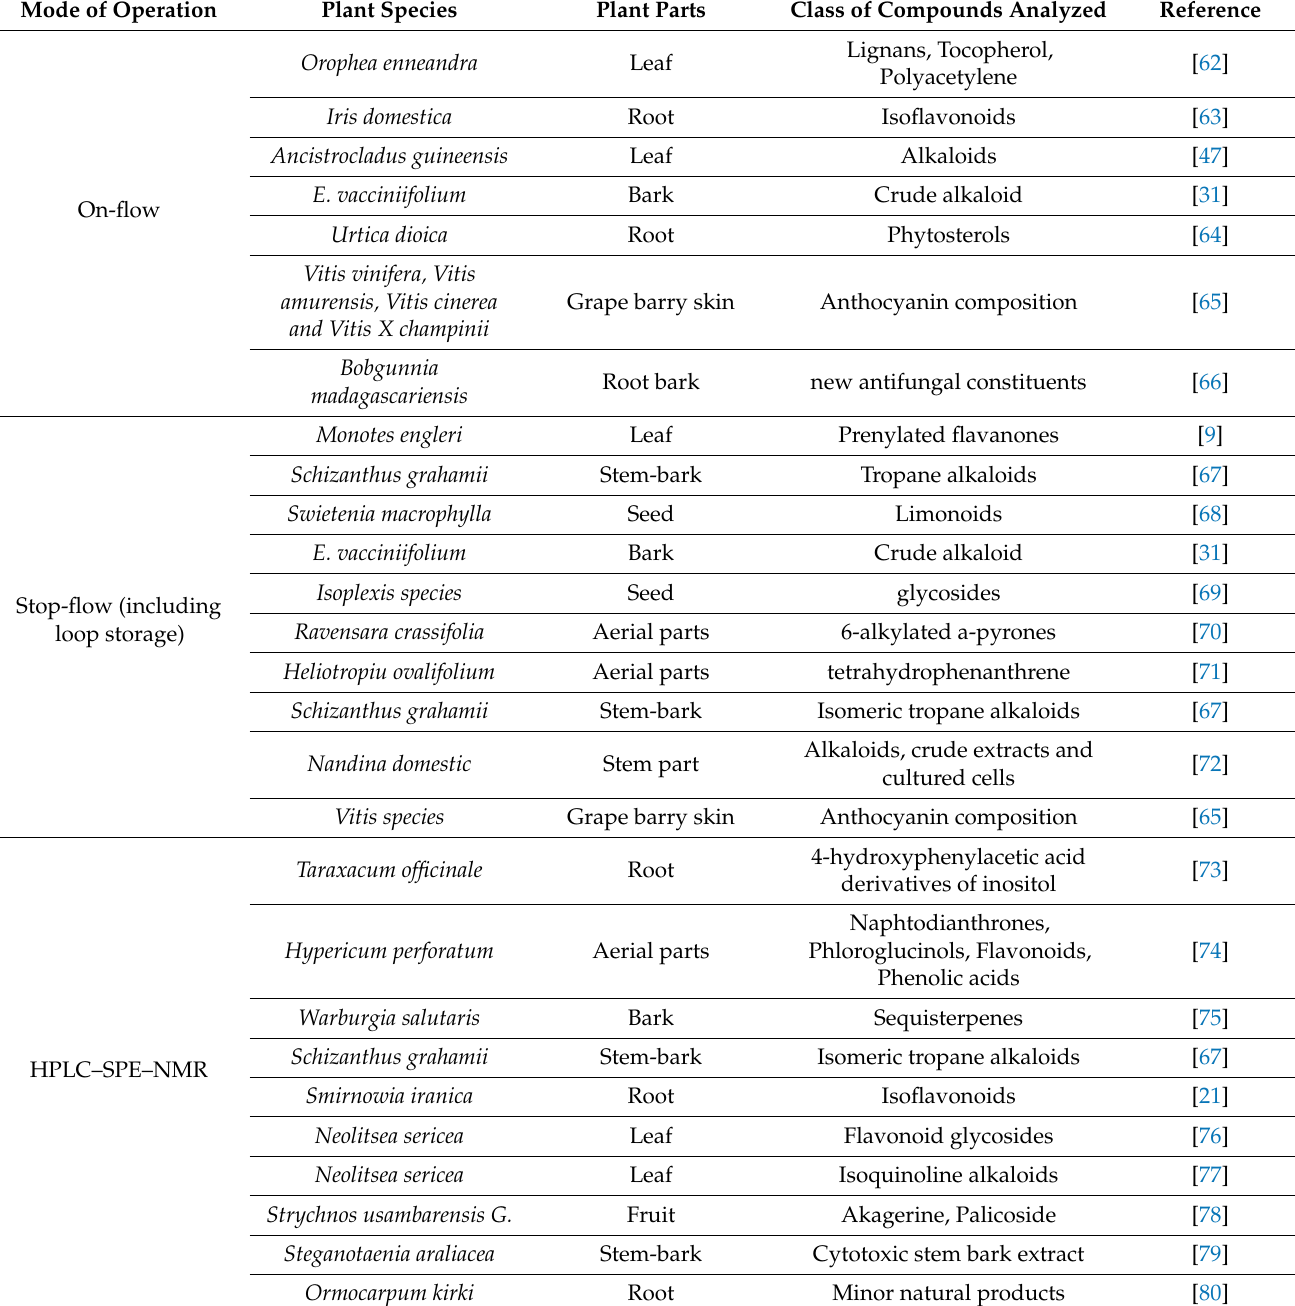
Table 2. Different LC–NMR and/or capillary LC (capLC)–NMR modes of operation and their application in natural product. Mode of